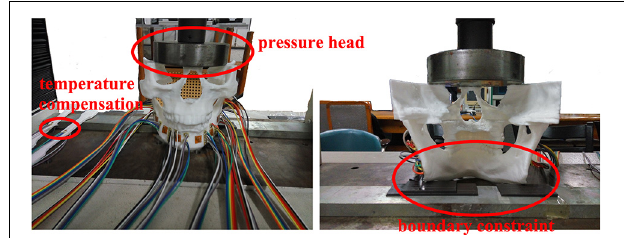
FIGURE 3 | The 3D experimental models of